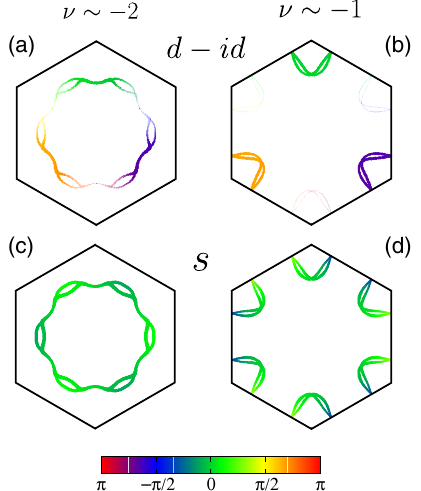
FIG. 14. Pair amplitudes Δ ð k Þ † of the leading superconducting channels: d − id wave (a),(b) and extended s wave (c),(d). In each panel we show the hexagonal MBZ and the phase amplitudes restricted to a narrow region close to the Fermi surfaces corresponding to the occupancies ν ∼ − 2 (a),(c) and ν ∼ − 1 (b),(d). The phase of the superconducting order parameter is expressed in color. Note that the double lines are due to the fact that two bands cross the chemical potential at different k